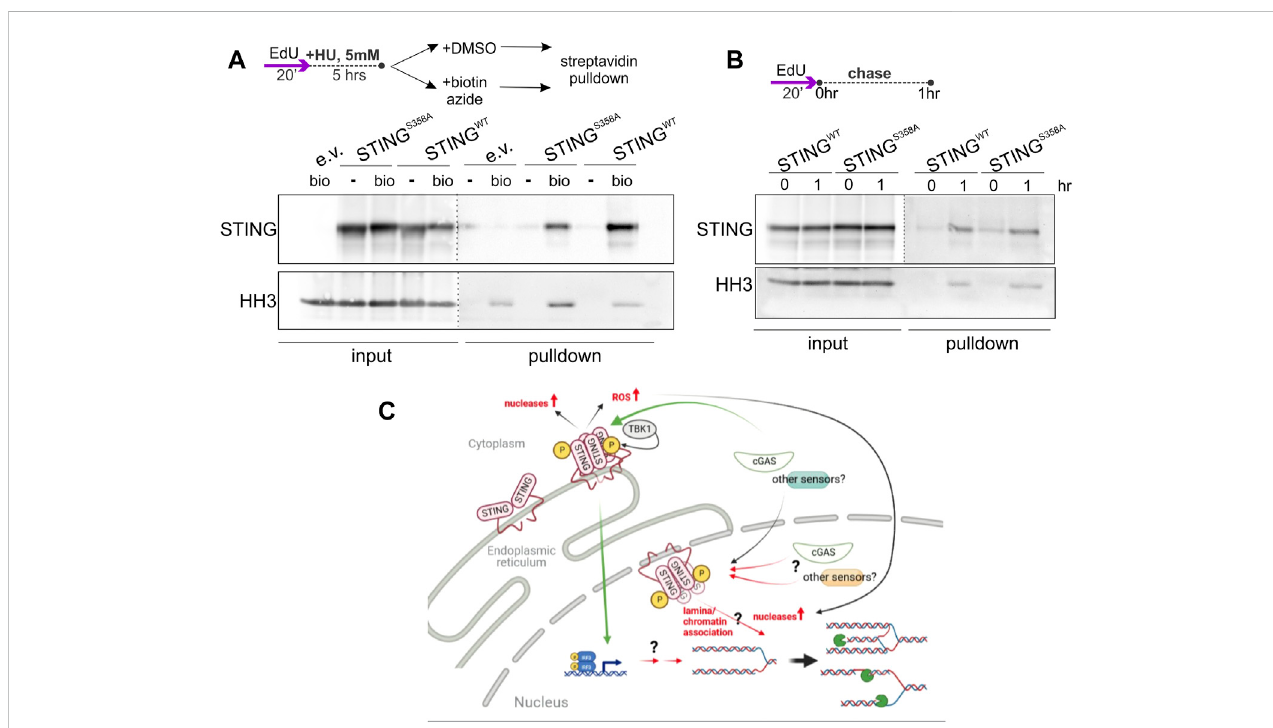
FIGURE 8 STING associates with chromatin in an immunoprecipitation of nascent DNA (iPOND) assay. (A) A schematic of EdU labeling, HU treatment, and sample preparation, and a Western blot of iPOND input and pulldown samples isolated from U2OS with the indicated transgenes or empty vector (e.v.), and probed with the STING and histone H3 (HH3) antibodies. Samples clicked with biotin azide: bio; mock-clicked samples: - . Dotted lines indicate different brightness settings and/or exposures of a Western blot image. (B) An EdU-labeling scheme and a Western blot of iPOND of samples of the same cells as in (A) , probed for STING and histone H3. (A,B) represent two independent experiments each. (C) A model for STING effect on nascent strand degradation, NDD. A canonical pathway via the ER-bound, activated STING to the transcriptional upregulation and/or ROS-mediated responses is a possibility that has not been ruled out. However, our data are consistent with the existence of an inner nuclear membrane pool of STING that is activatable and can participate in the regulation offork metabolism via association with lamina and chromatin, or, similarly to theER STING, that facilitates upregulation ofthe activityand/orlevels of nucleases. Green arrows indicate canonical mechanisms. Black arrows indicate the documented relationships that may be drawn upon to explain STING ’ s effect on NDD. Red arrows are the proposed novel mechanisms. Pacman symbols indicate nucleolytic processing of stalled forks. The model was generated with